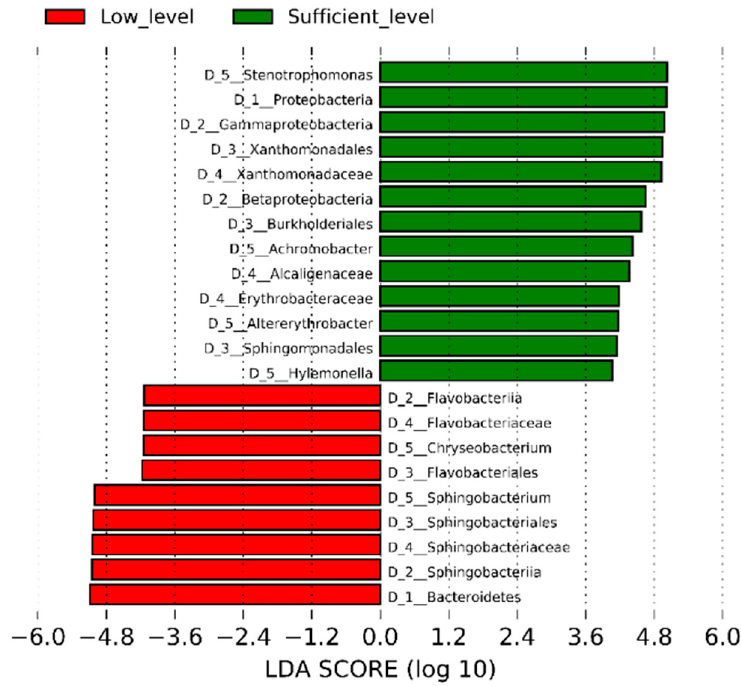
Figure 5. The linear discriminant analysis effect size (LEfSe) analysis of predicted microbial taxa in deficient-nitrogen-level (red) and sufficient-nitrogen-level (green) samples.